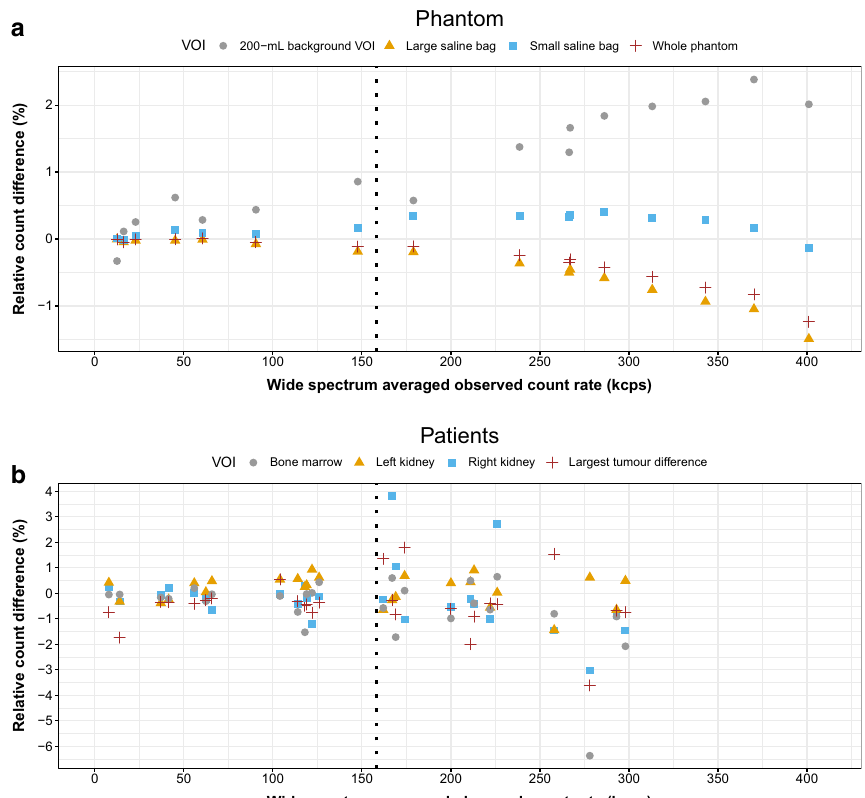
Fig. 3 Relative count difference per VOI between SPECT corrected for dead time using DTCM1 versus DTCM3, in function of the observed wide‑spectrum acquisition count rate (phantom, a ; patients, b ). The dotted line at 158 kcps corresponds to a DTCF equal to 1.1. Tumours are represented by the one tumour per acquisition having the largest difference between DTCM3 versus DTCM1